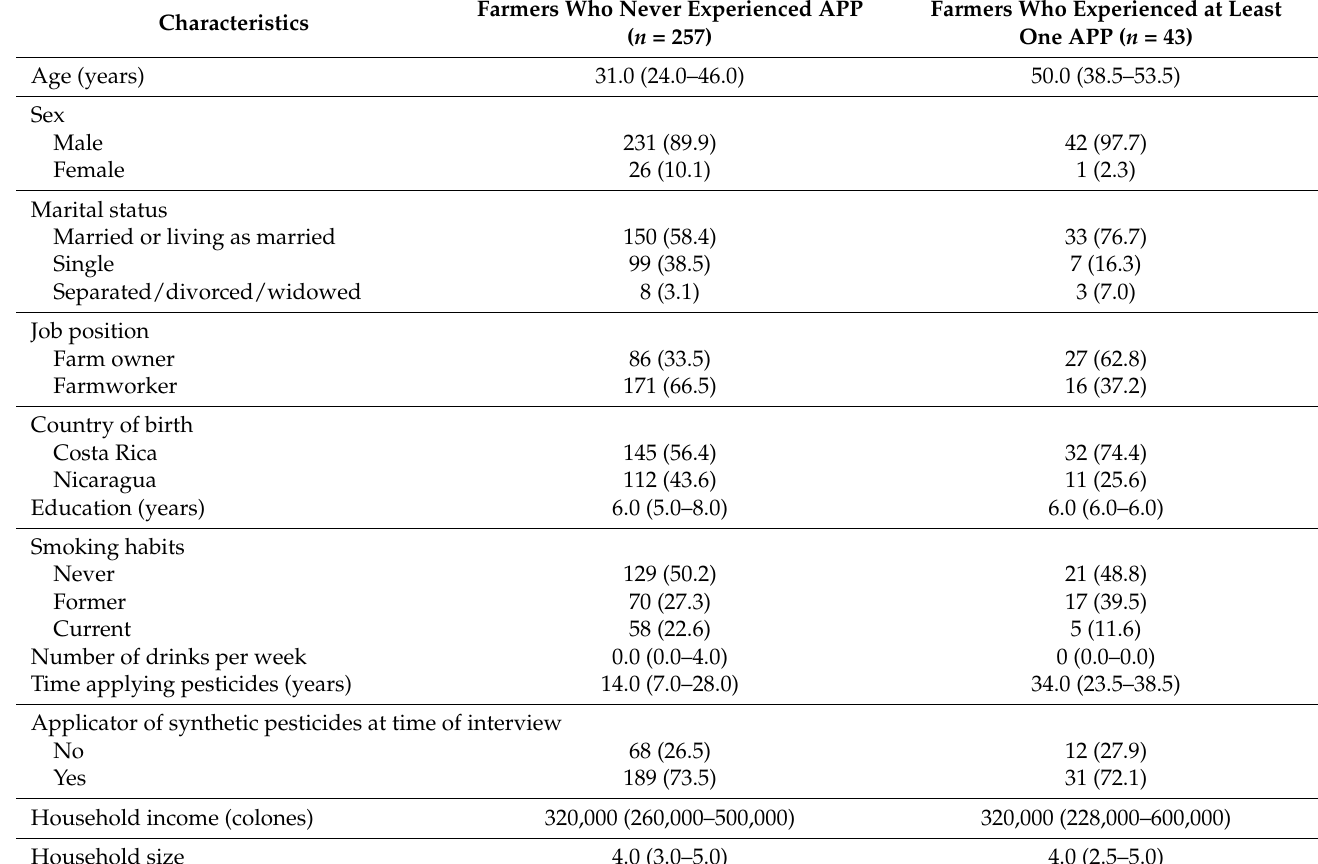
Table 1. Socio-demographic and occupational characteristics of the study population ( n (%) or median (P25–P75)), Zarcero County, Costa Rica, 2016, disaggregated by those who had experienced at least one acute pesticide poisoning (APP) and those who had not. World Health Organization (WHO) pesticide toxicity classifications were used.